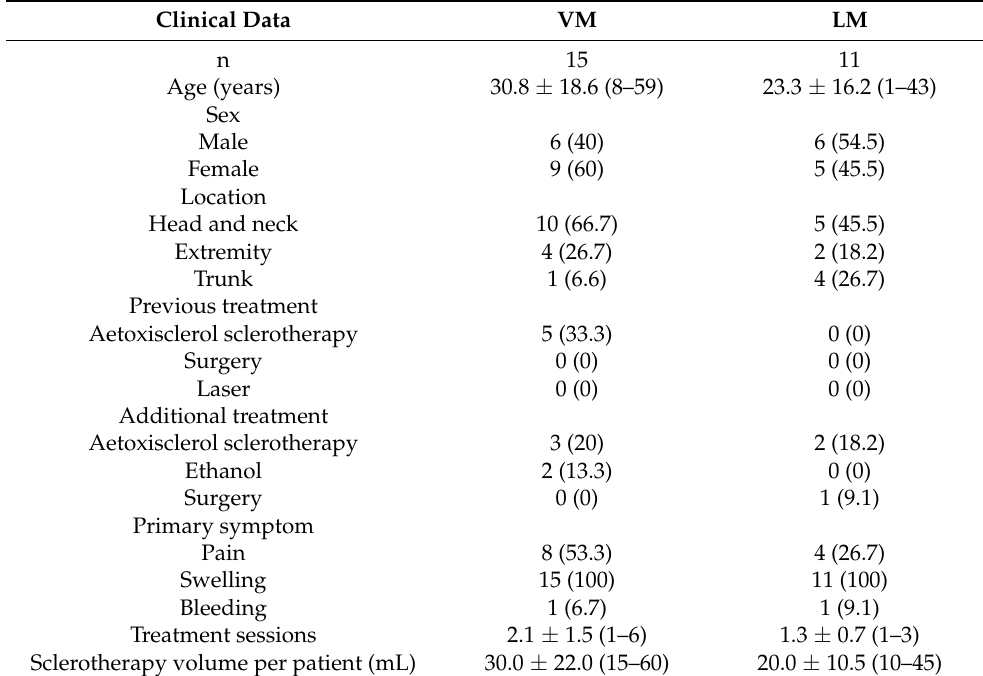
Table 1. Characteristics of the 26 patients and sclerotherapy